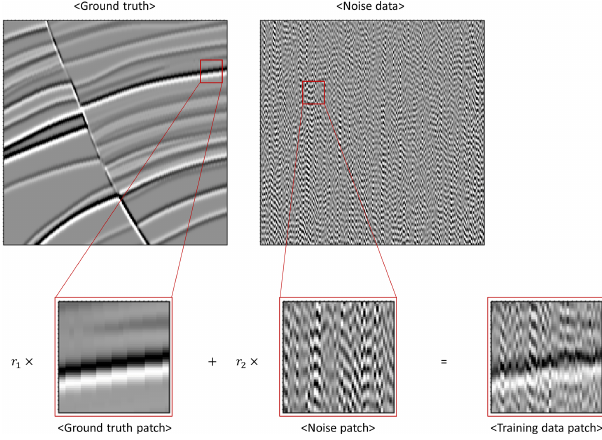
Figure 6. Example of constructing the training